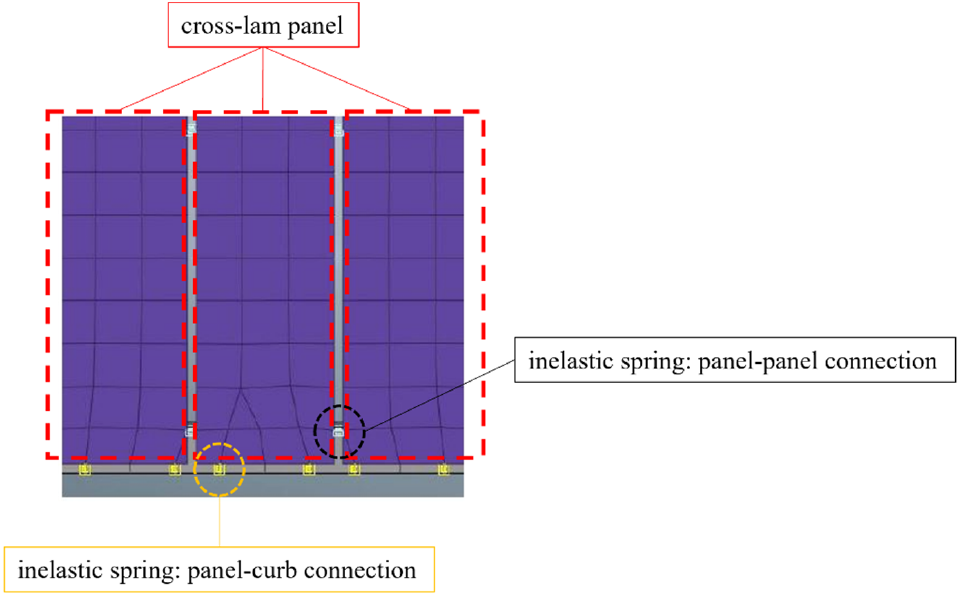
Figure 14. Modeling of the panel–panel and panel–curb connections. Table 8. Mechanical properties of the cross-laminated panel.